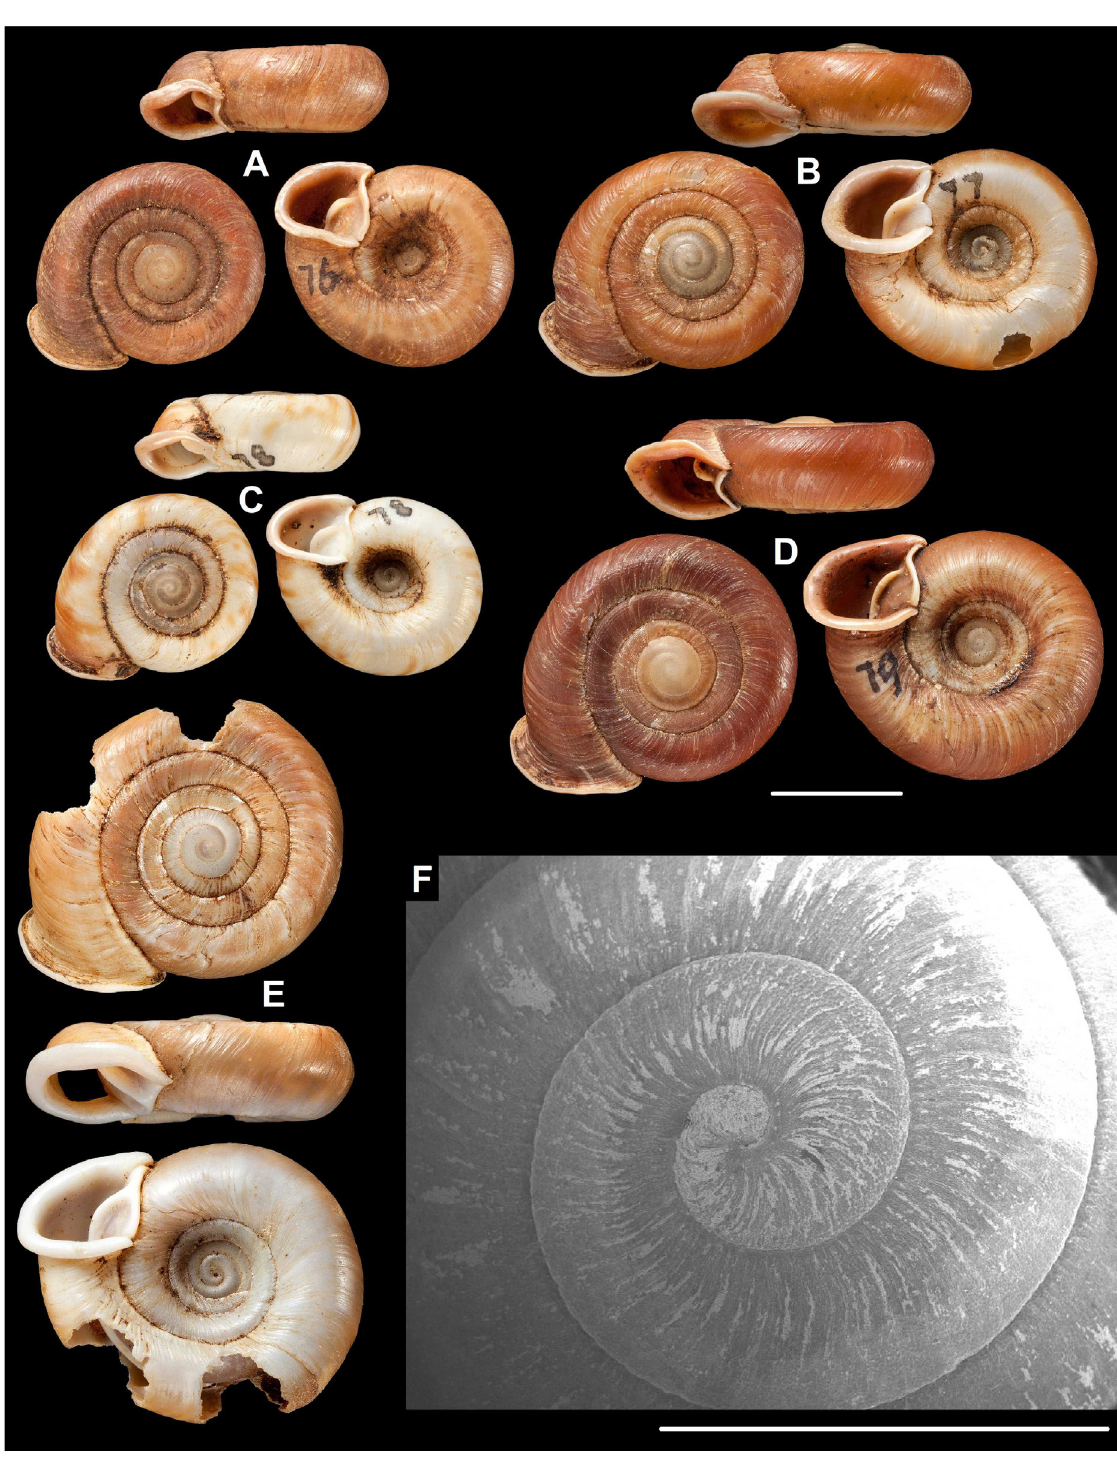
Fig. 36. Shells of Plectopylis bensoni Gude, 1914. A . Holotype of var. obesa Gude, 1898 (NHMUK 1922.8.29.42). B . Holotype of var. infrafasciata Gude, 1898 (NHMUK 1922.8.29.43). C . Holotype of var. venusta Gude, 1898 (NHMUK 1922.8.29.44). D . Holotype of var. castanea Gude, 1898 (NHMUK 1922.8.29.45). E . Holotype of var. repercussoides Gude, 1899 (NHMUK 1922.8.29.46). F . Protoconch of Plectopylis bensoni , loc. 20091014C (coll. PGB). Scale bars: A–E (upper scale) = 10 mm; F (lower scale) = 2 mm. Images: H. Taylor (A–E) and B. Páll-Gergely